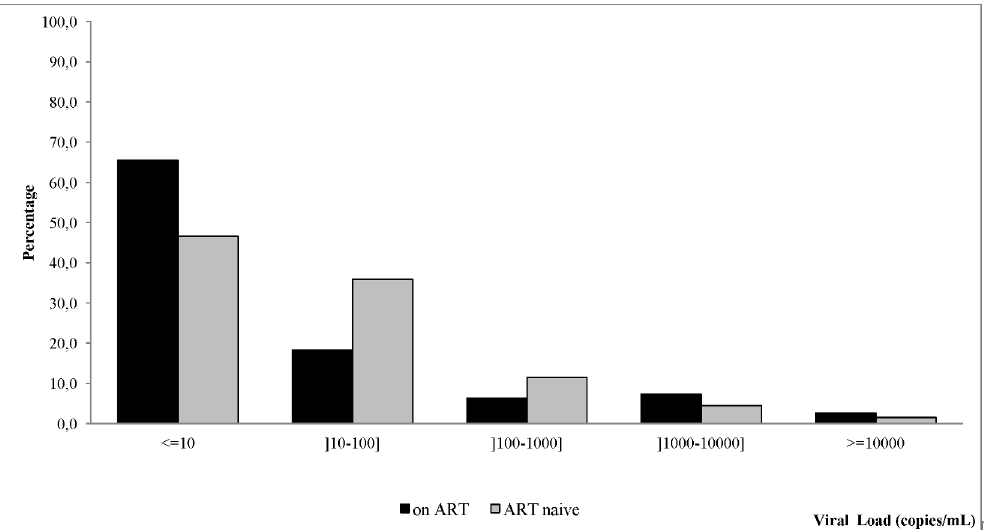
Fig 1. Distribution of viral load according to antiretroviral therapy initiation among HIV-2 infected individuals in West Africa.